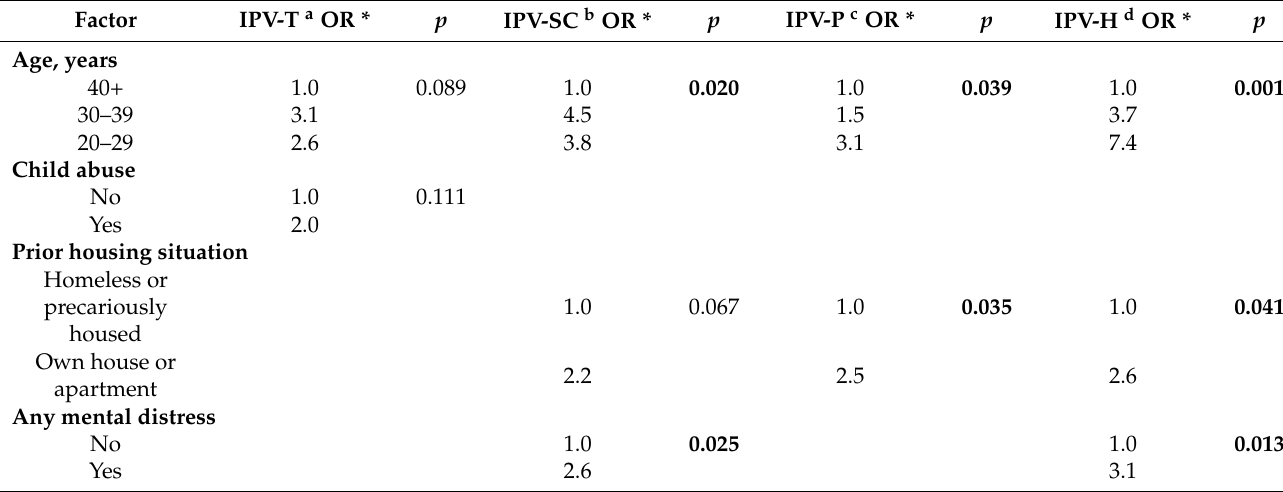
Table 4. Logistic regression models of IPV by